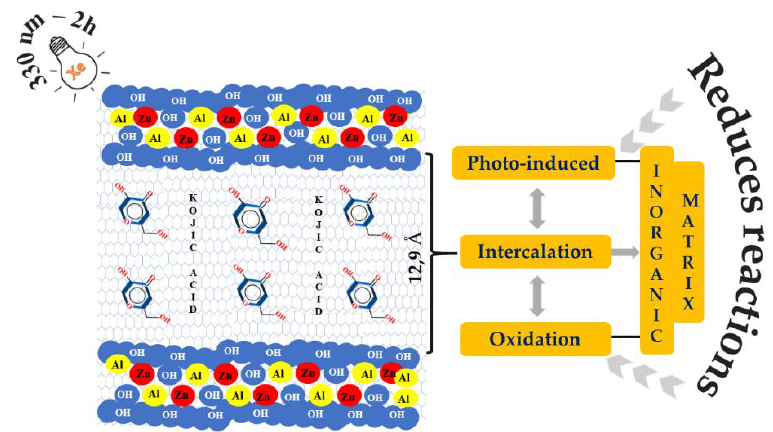
Figure 4. Representation of study of Kojic acid-hydrotalcite hybrid from Ambrogi et al. 2012. Adapted with permission from ref. [80]. 2022, Elsevier